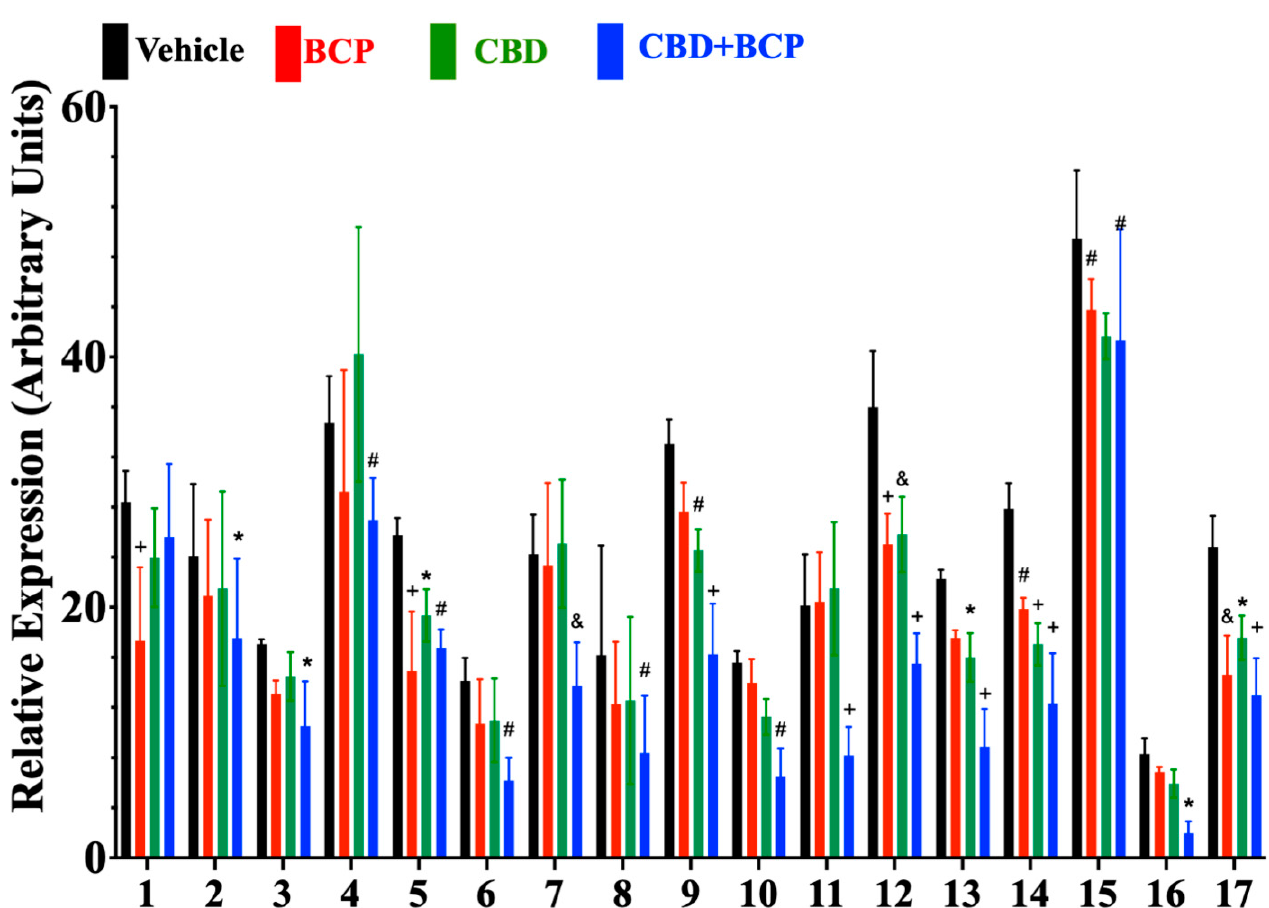
Figure 2. Effects of BCP, CBD, and combination on cytokine expression ( n = 4). List of cytokines 1 (C1qR1), 2 (EGF), 3 (ICAM-1), 4 (IGFBP-1), 5 (IGFBP-3), 6 (IGFBP-5), 7 (IGFBP-6), 8 (IL-33), 9 (LIX), 10 (MMP-2), 11 (MMP-3), 12 (pentraxin 2), 13 (PCSK 9), 14 (REg3G), 15 (E-selectin), 16 (VCAM-1), and 17 (VEGF). Bars correspond to the group means ± SEM. * p < 0.05; # p < 0.01; & p < 0.001; + p < 0.0001. BCP (2.2 mg/kg) reduced expression of five cytokines (Figure 2): C1qR1 ( p < 0.0001), IGFBP-3 ( p = 0.0001), Pentraxin 2 ( p = 0.0001), REG3G ( p = 0.0070), VEGF ( p = 0.0004). The CBD (2 mg/kg) + BCP (2.2 mg/kg) combination reduced expression of 16